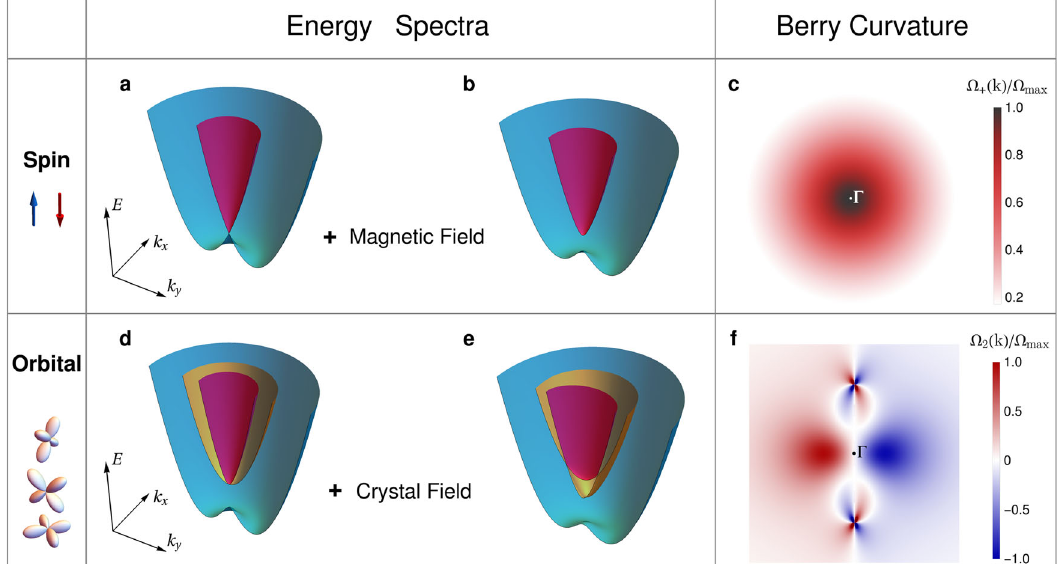
Fig. 1 Spin and orbital mechanisms of Berry curvature. a Schematic band structure of a two-dimensional electron gas with Rashba spin – orbit coupling. b An out-of-plane magnetic fi eld breaks the Kramers' degeneracy at k = 0 and triggers a fi nite BC. c The local BC has a circular pro fi le with an hot spot at the Γ point of the BZ. d Schematic band structure of a two-dimensional electron system characterized by an L = 1 orbital multiplet in a trigonal crystalline environment. e An additional crystalline symmetry lowering splits completely the energy levels at the Γ point of the BZ even if time-reversal symmetry is preserved. The presence of mirror symmetry protects crossing at fi nite momenta. f A characteristic time-reversal symmetric BC pro fi le with the presence of hot-spots and singular pinch points. The BC has been obtained using the model Hamiltonian Eq. (5) with Δ ¼ (cid:2) 0 : 2 E 0 , Δ m ¼ 0 : 12 E 0 , α R ¼ 1 : 0 E 0 = k 0 Fermi wavevector.